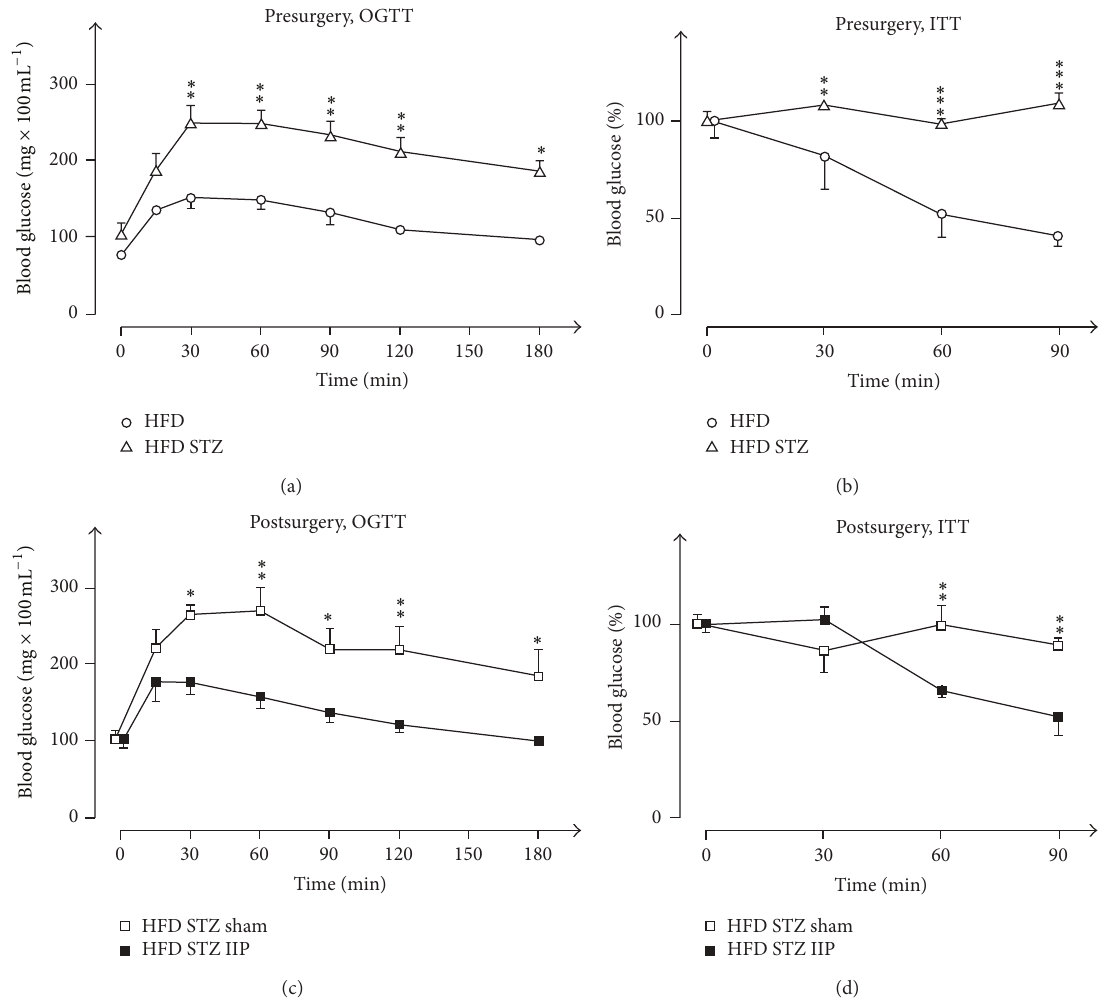
Figure 4: Effects of STZ treatment ((a), (b)) and IIP surgery ((c), (d)) on oral glucose tolerance ((a), (c)) and insulin tolerance ((b), (d)). Before surgery: oral glucose tolerance tests (OGTTs) in (a) and insulin tolerance tests (ITTs) in (b) were performed during the 12th week of life in 9 animals that did not receive STZ (HFD) and in 18 animals that were treated with STZ (HFD STZ). After surgery: OGTTs (c) and ITTs (d) were performed during the 15th week of life in STZ-treated animals that had been sham-operated (HFD STZ sham, 9 animals) and in STZ-treated animals that had been IIP-operated (HFD STZ IIP, 9 animals). Mean values ± SEM are indicated. ∗ 𝑝 < 0.05 , ∗∗ 𝑝 < 0.01 , and ∗∗∗ 𝑝 < 0.001